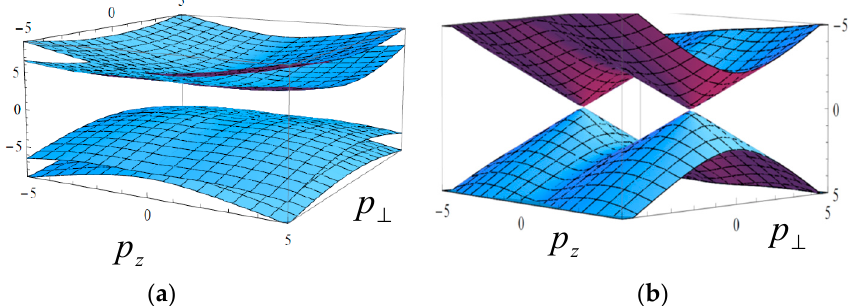
Figure 2. Energy surfaces for different regions of the parameters: Left panel ( a ) is for the case 𝑀 > 𝑞/2 , while right panel ( b ) is for the case 𝑀 < 𝑞/2 .